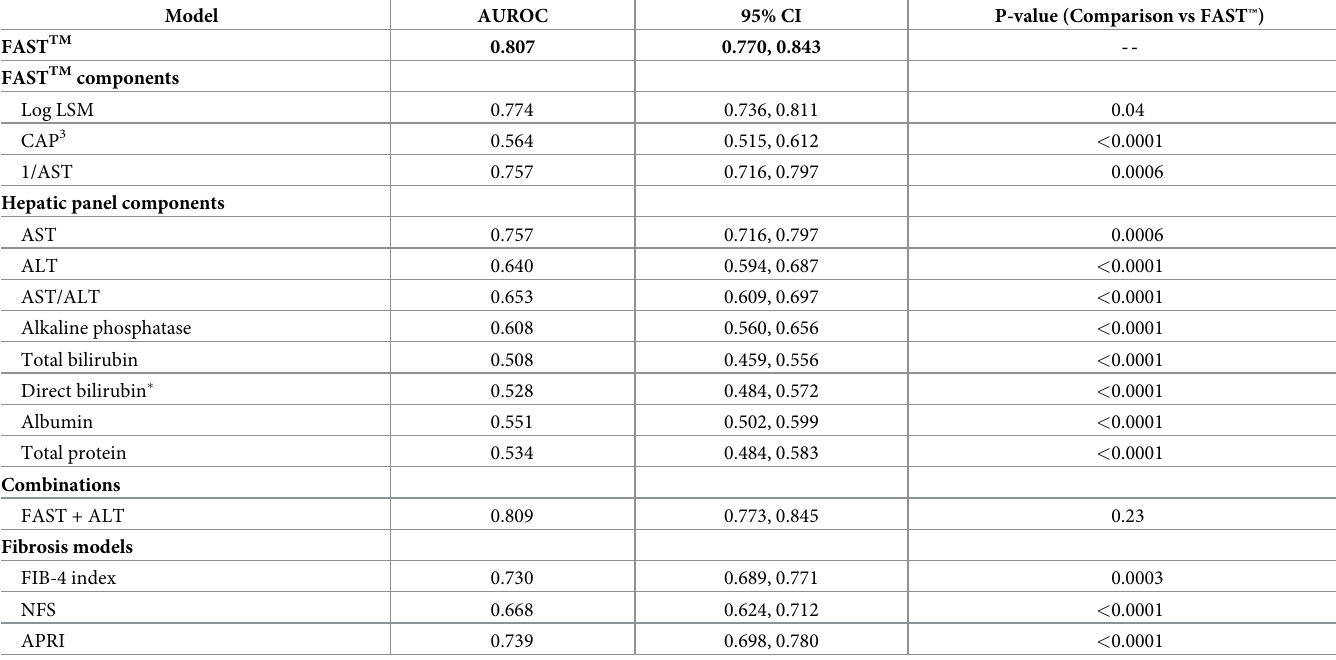
Table 5. Comparison of various diagnostic models for at-risk NASH vs. FAST ™